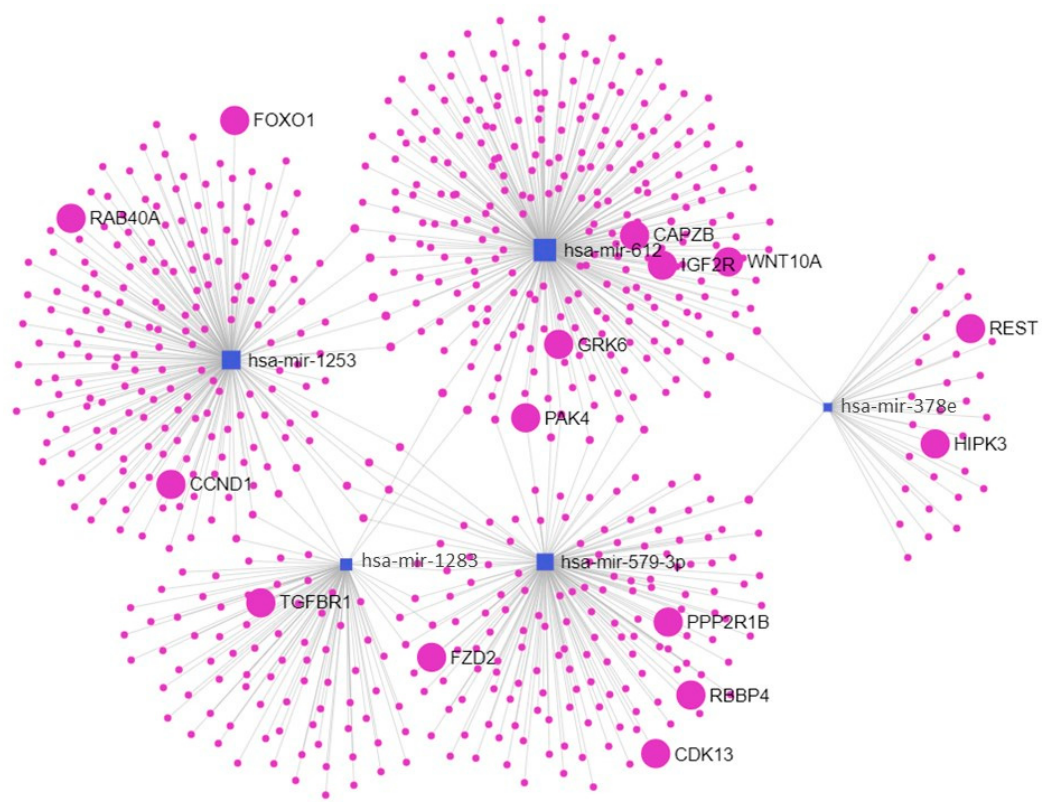
Figure 2. miRNA-target gene interaction networks. Squares represent the differently expressed miRNAs (miR-612, miR-1253, miR-1283, miR-378e, and miR-579-3p). Circles represent target genes and highlighted circles (larger circles) represent genes from major pathways involved in prematurity. This figure was generated using the miRNet 2.0 tool (https://www.mirnet.ca/ accessed on 13 February 2023).